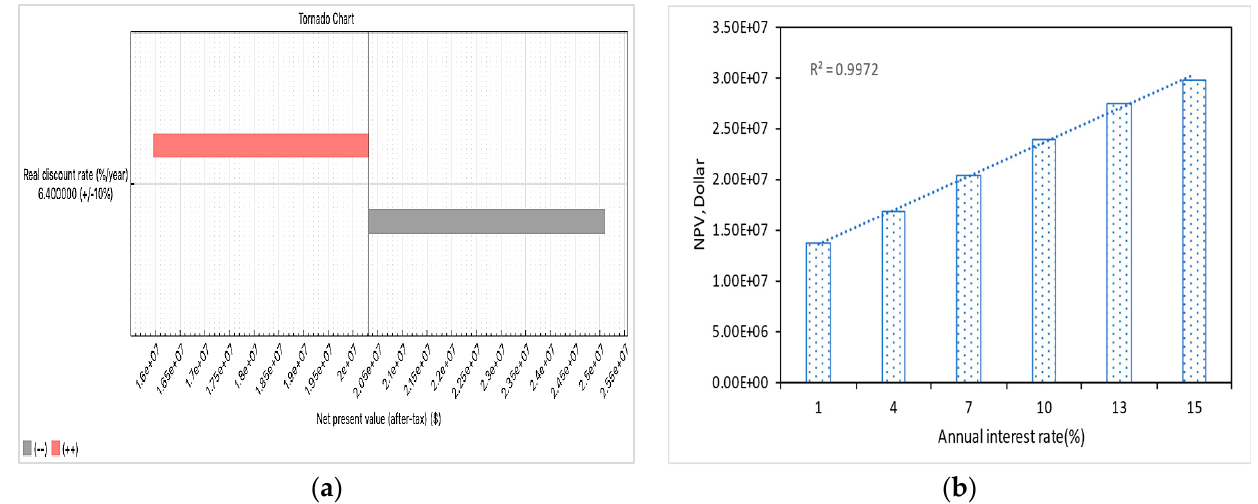
Figure 13 . Sensitivity of NPV towards ( a ) real discount rate and ( b ) annual interest rate .